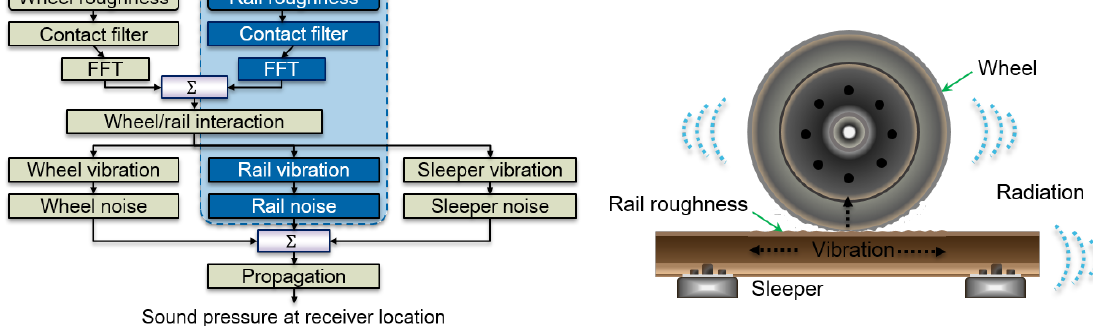
Figure 1. Model of rolling noise generation.